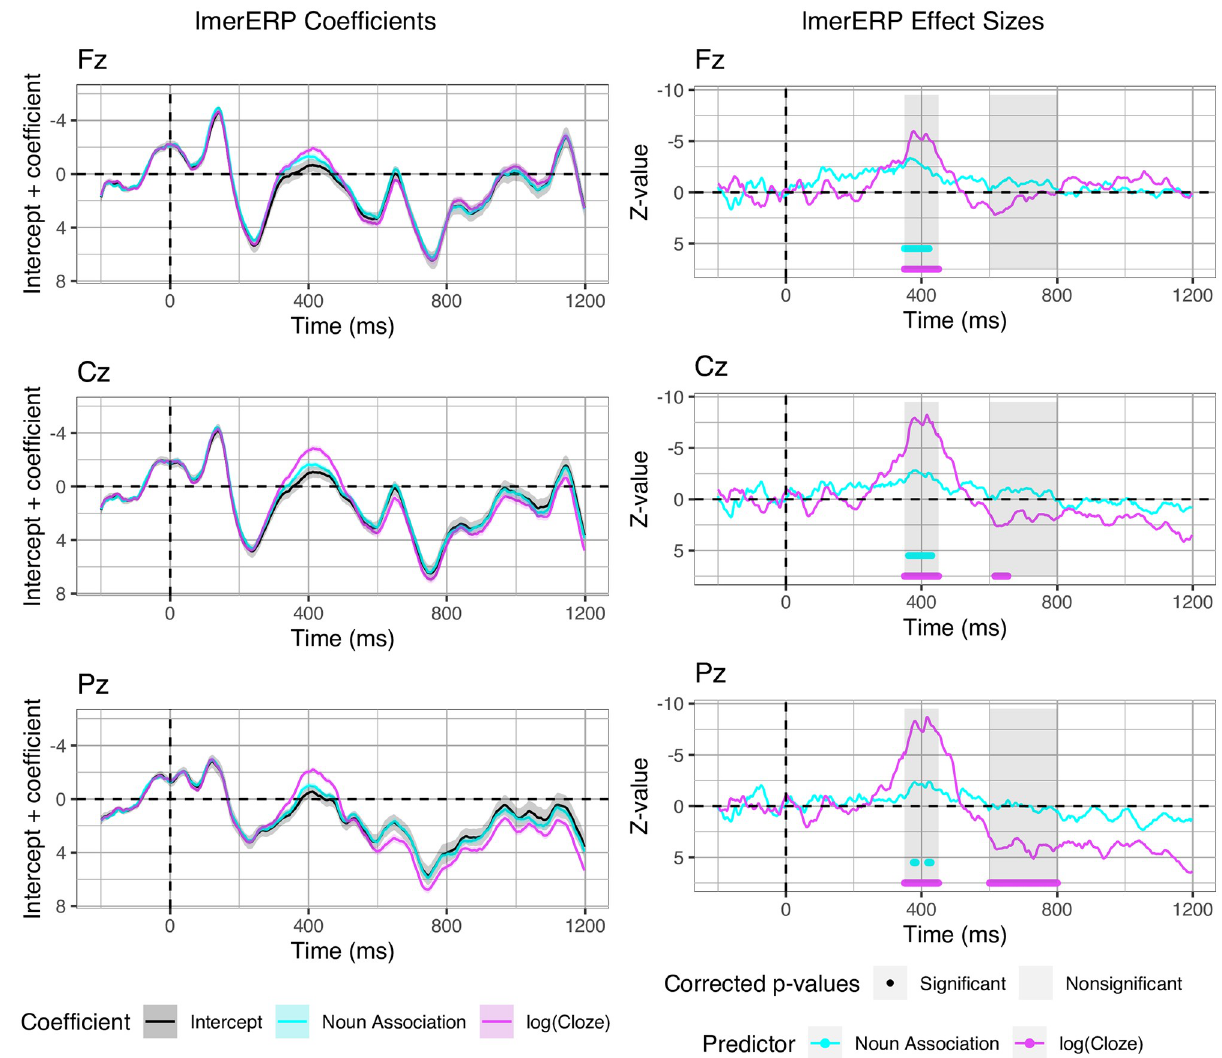
Fig 6. ERP coefficients and z-values. Coefficients (left; added to their intercept), effect sizes (z-values) and corrected p-values (right) from the lmerERP model with log(Cloze) and noun-target association as predictors. Ribbons indicate the standard error on the coefficients from the statistical model.